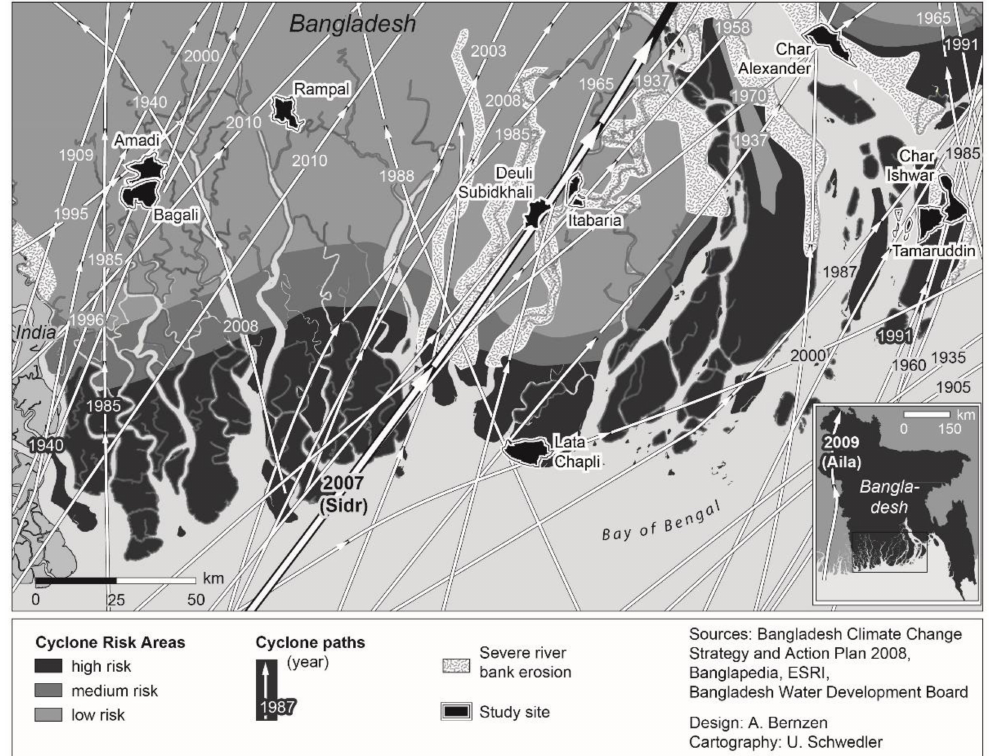
Figure 1. Study sites, risk areas and cyclone paths in coastal Bangladesh. Source: Own